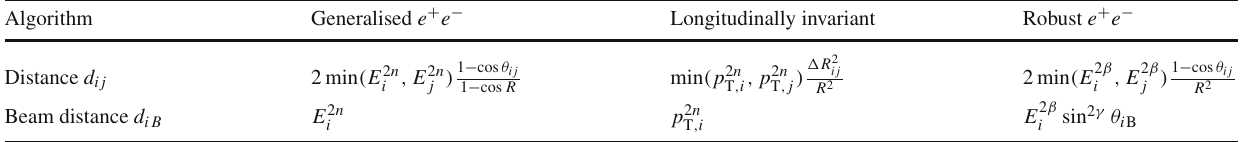
Table 1 Summary of the distance criteria used in sequential recom- bination algorithms. Generalised inter-particle and beam distances are givenforthreemainclassesofalgorithms:theclassical e + e − algorithms (comprisingaversionwithbeamjetsoftheCambridge[17]andDurham